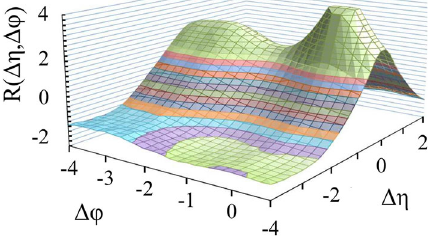
Fig. 4 The R (Δη,Δϕ) distribution simulated with FANSY 2.0 CPG (“moderate”) at | Δη | ≤ 4 for minimum bias